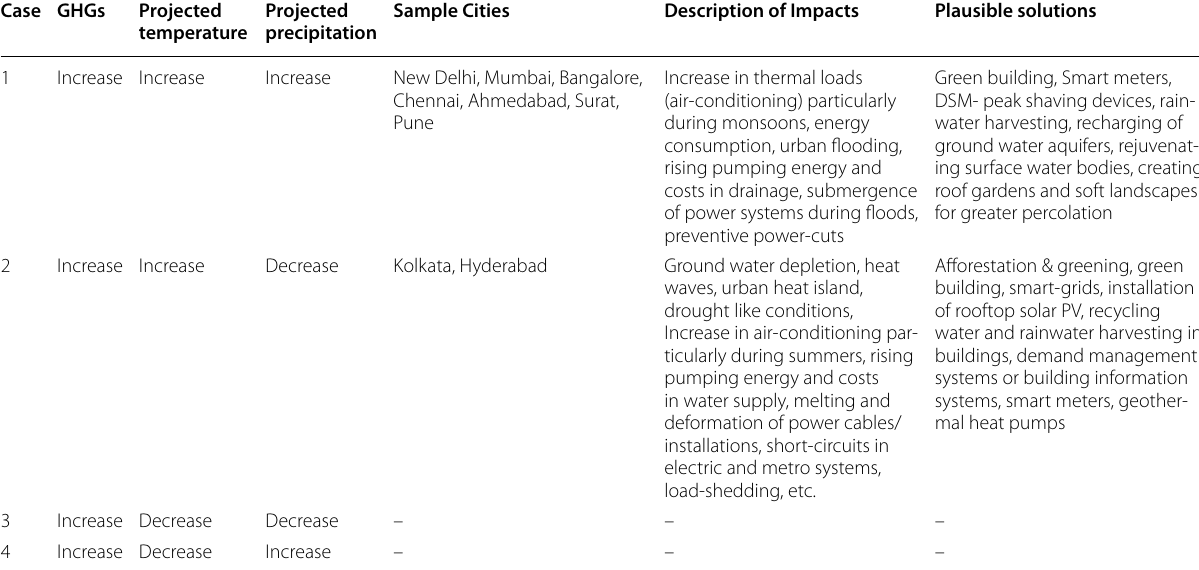
Table 1 Description of impacts and plausible solutions for sample of Indian cities experiencing different GHG, temperature and precipitation in